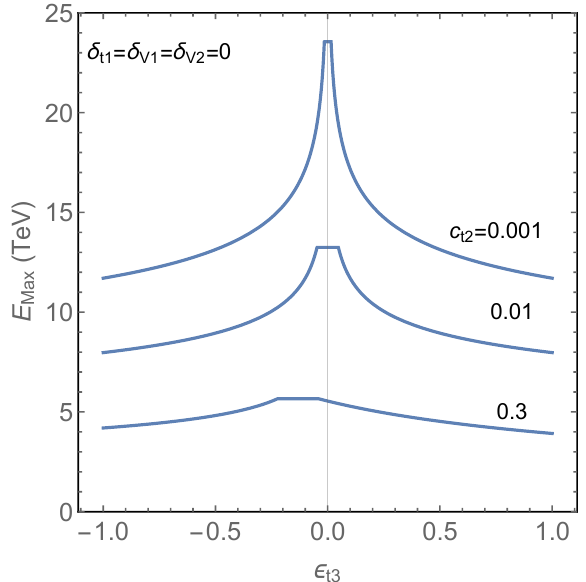
Figure 17 . The unitarity bound from processes that depend only on c t 2 and c t 3 = 6 c t 2 (1+ (cid:15) 3 ) when δ t 1 = δ V 1 = δ V 2 = 0 . Setting (cid:15) t 3 = 0 corresponds to the SMEFT prediction from the dimension-8